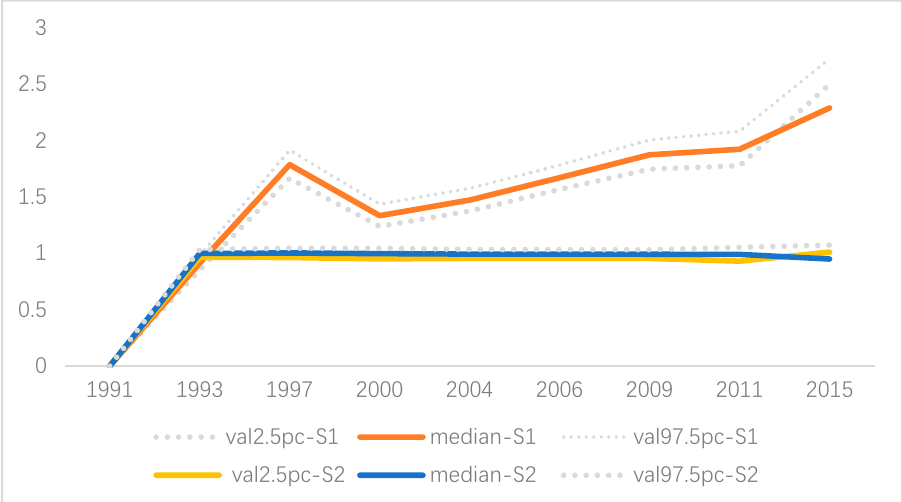
Figure 9. Gender-specific temporal effects ( j = 1 for male; j = 2 for female).